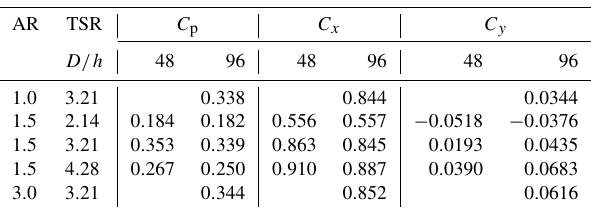
Table 1. H-VAWT global performance: effects of aspect ratio, TSR, and spatial